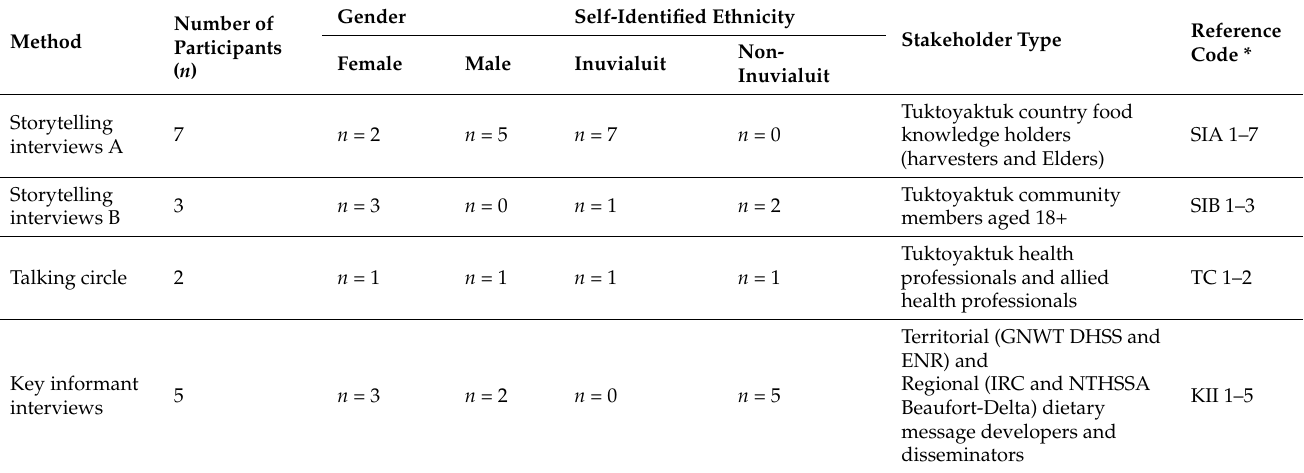
Table 2. Participant characteristics and reference codes categorized by research